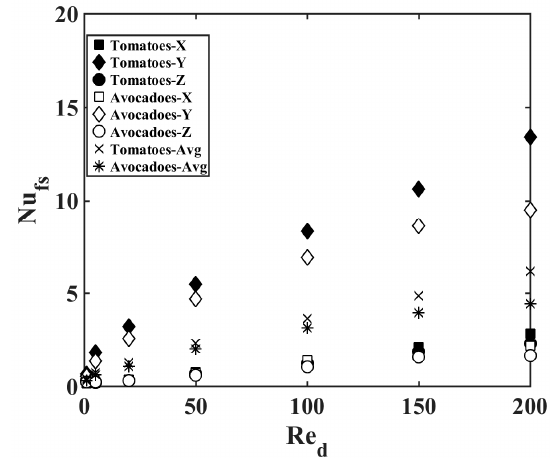
Figure 10. Nusselt number as a function of Reynolds number for tomatoes and avocadoes over the range of conditions considered.